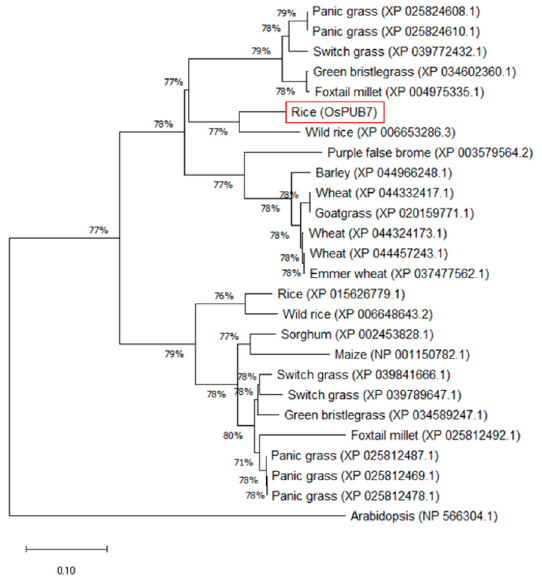
Figure 1. Phylogenetic analysis of OsPUB7 in various plant species. The phylogenetic tree was constructed using the neighbor-joining method of MEGAX. The numbers represent bootstrap values from 1000 replicates.